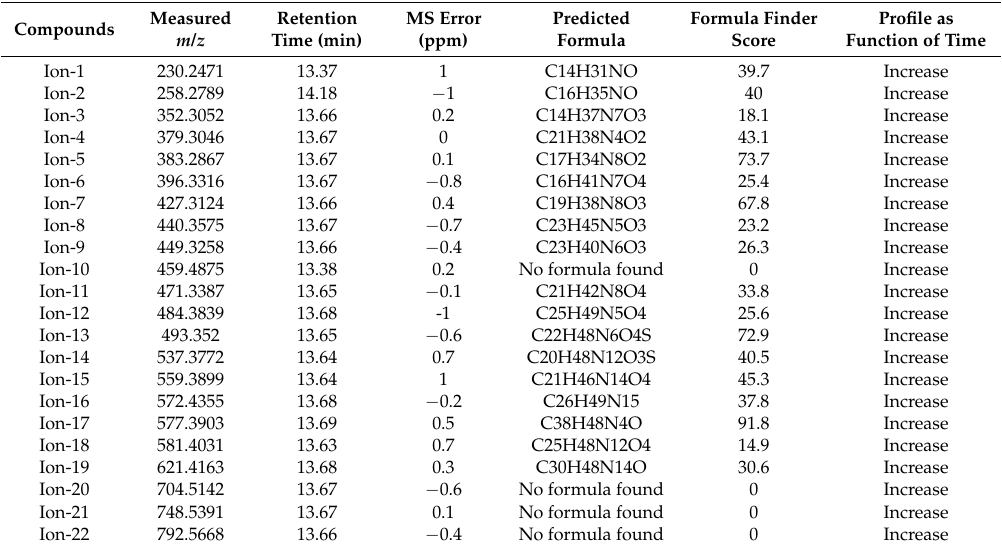
Figure 4. Total ion chromatogram acquired for both ( a ) photolysis and ( b ) photocatalysis in the presence of HApTi comparing time zero with respect to time 24 h. Table 2. DCF photo-transformation products detected in positive ionization mode in the 24-h photolysis sample.